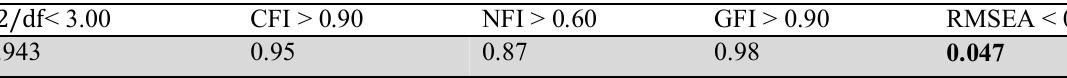
Fit indices of structural model